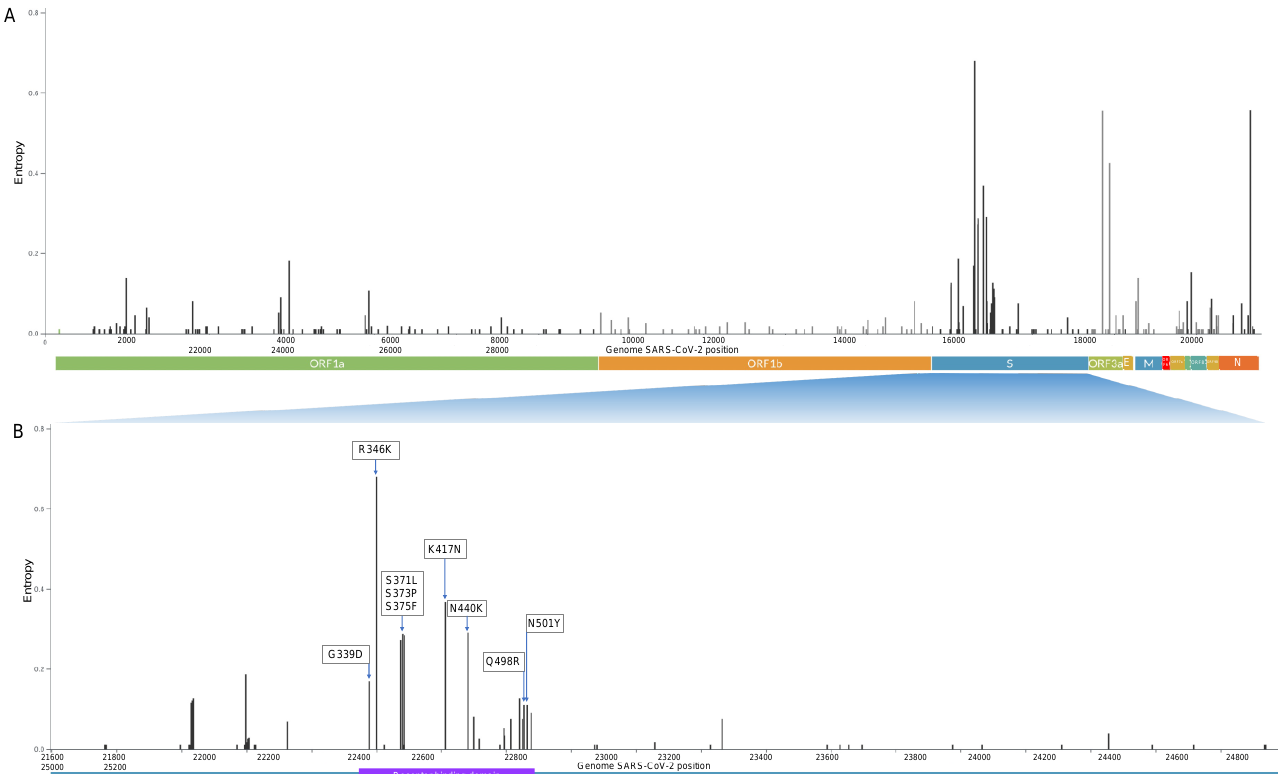
Figure 3. ( A ) Genome map of the SARS-CoV-2 Omicron variant with the most representative amino acid substitutions in 783 Omicron genomes in Mexico City with genome coverage >95%. Whole- genome SARS-CoV-2. ( B ) Spike protein with receptor-binding domain. The y-axis corresponds to the entropy calculated by the Nextclade tool.